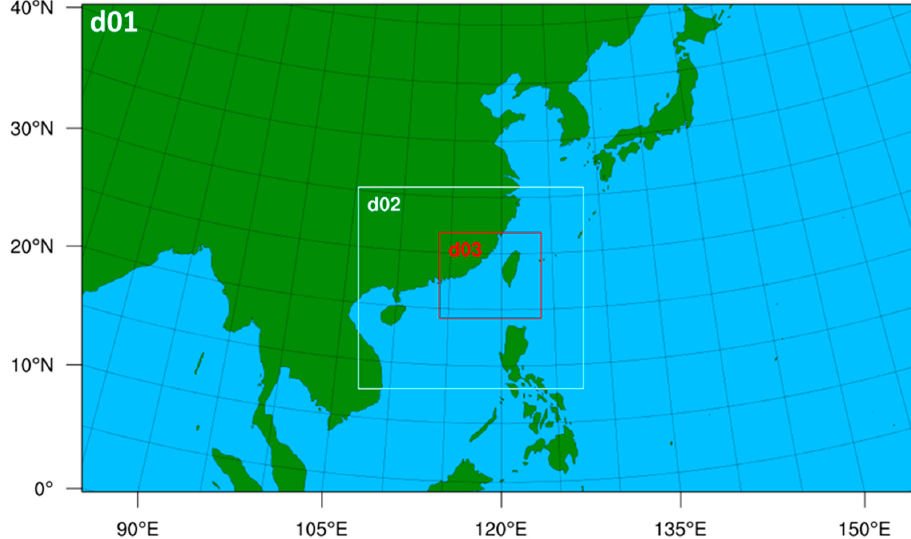
Figure 3. The three nested domains (d01, d02, and d03) in the NWP model experiment in this study. The spatial resolutions and horizontal grids of these three domains are 45-, 15-, and 5-km (or 180 by 105, 145 by 130, and 196 by 166), respectively.